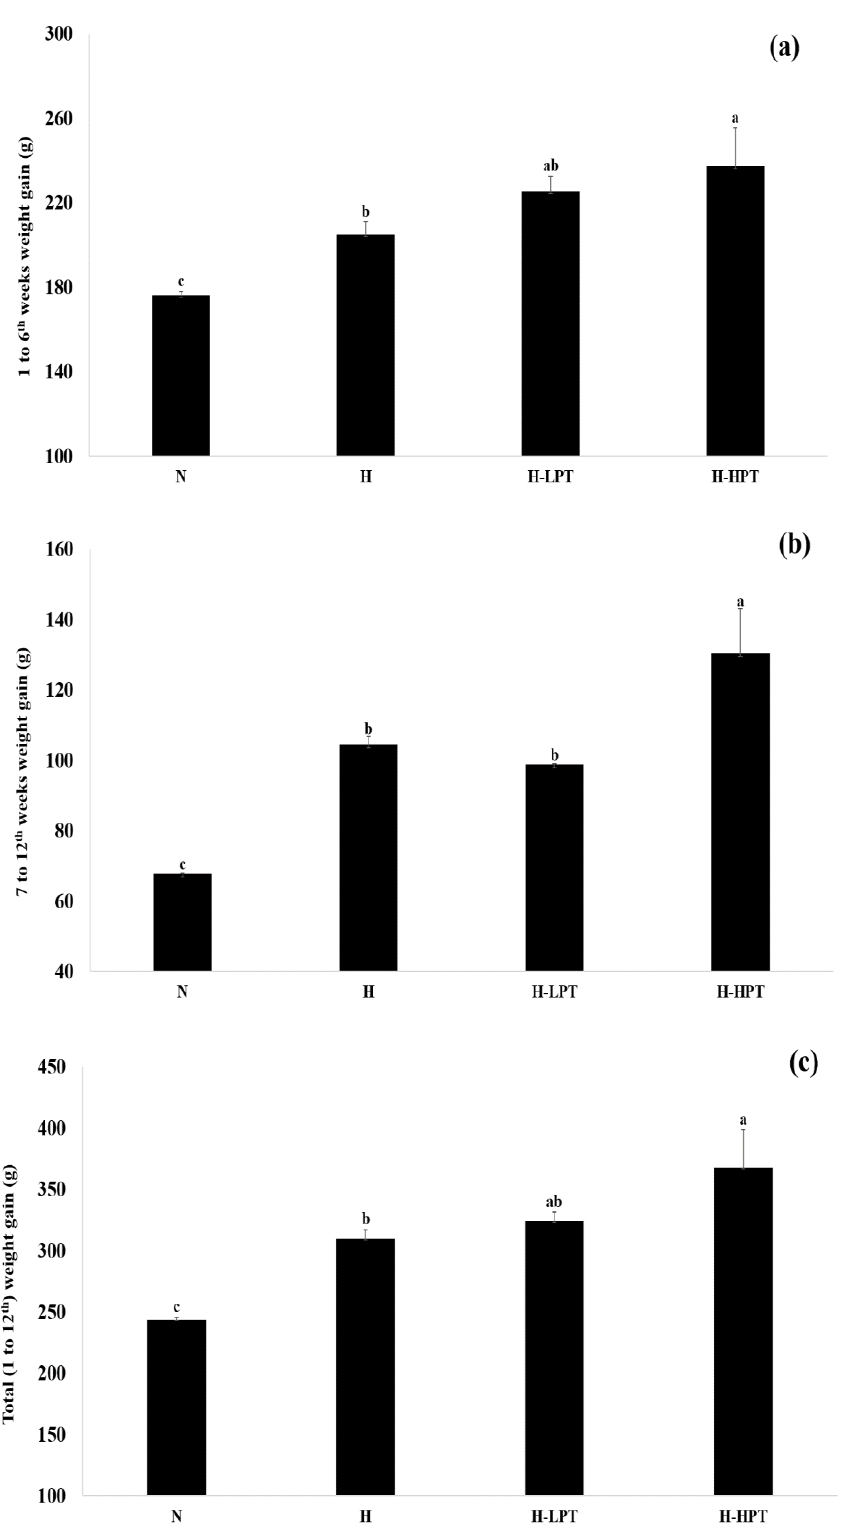
Figure 3. Comparisons of body weight gains between groups during the entire intervention period (from 1 to 12th weeks). ( a ) Weight gain during the period from 1 to 6th weeks, ( b ) weight gain during the period from 7 to 12th weeks, and ( c ) total weight gain during the periods from 1 to 12th weeks. Mean with different letters (a–c) corresponds the significant difference calculated by the non-parametric Friedman test followed by Dunn’s test ( p < 0.05).